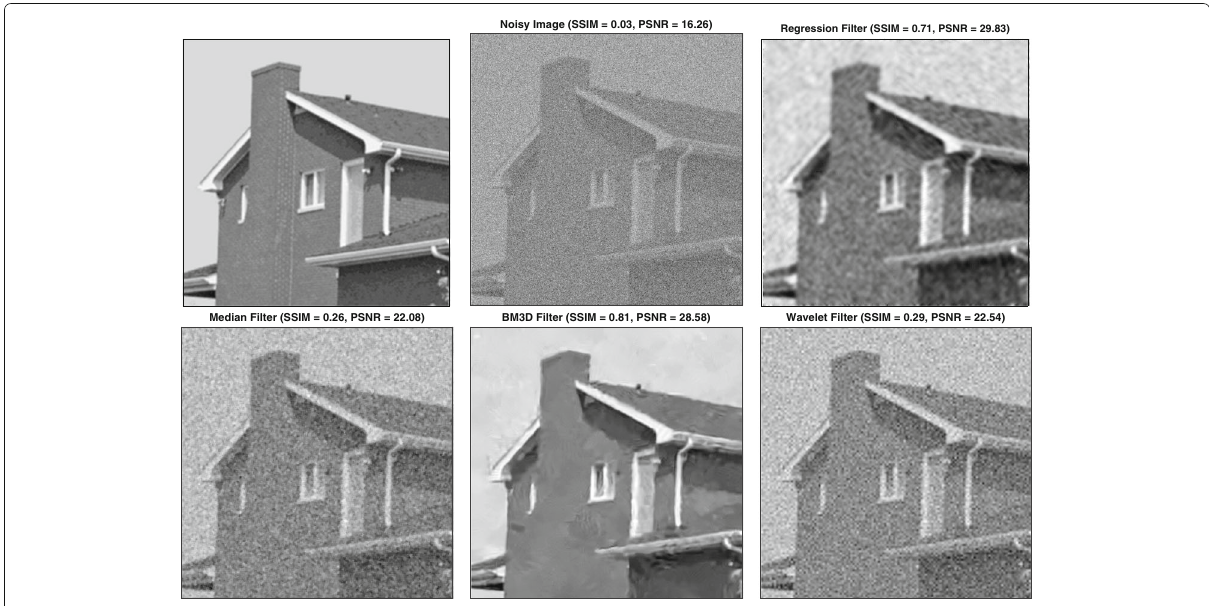
Fig. 7 Added Gaussian noise with σ = 100. From left to right: a clean house, b noisy image, c denoised image using our L 2 regression filter, d denoised image using median filter, e denoised image using BM3D, and f denoised image using wavelet filter